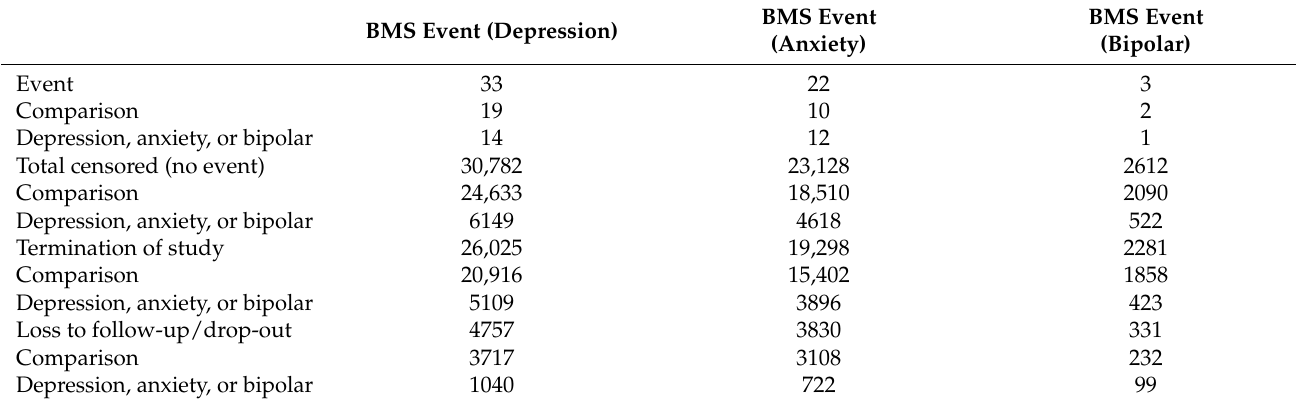
Table 1. Description of time to event and censored